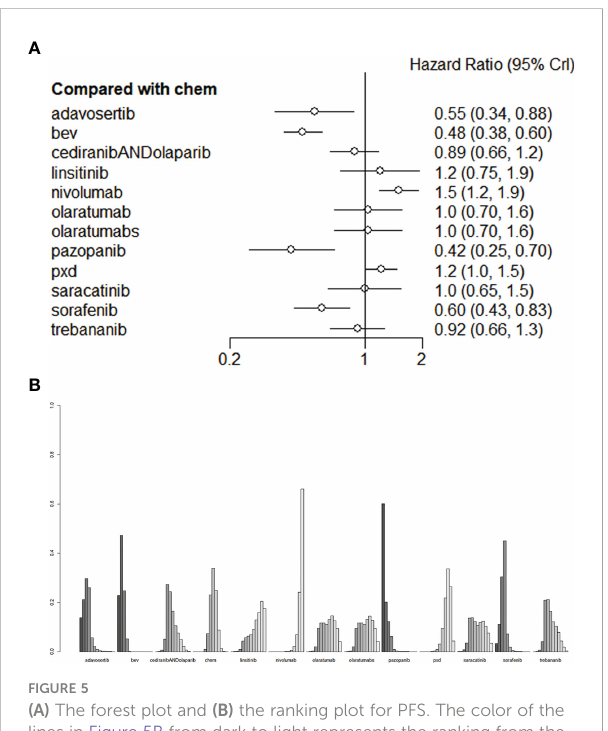
FIGURE 5 (A) The forest plot and (B) the ranking plot for PFS. The color of the lines in Figure 5B from dark to light represents the ranking from the best to the worst. A darker color represents a higher probability of becoming the best intervention, and a lighter color represents a lower probability. The cediranibANDcediranib stands for combination